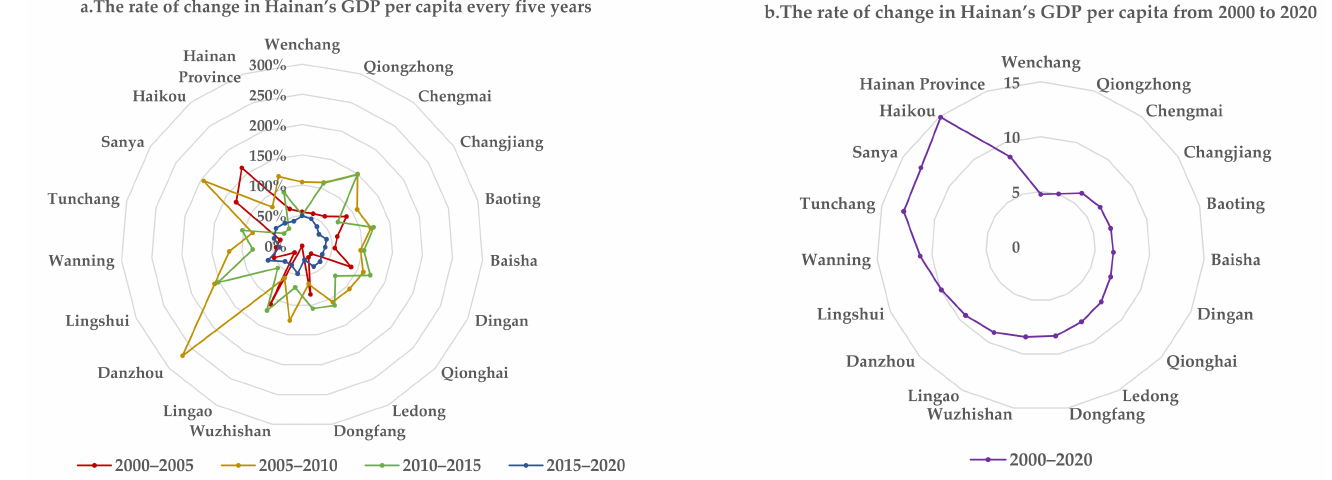
Figure 11. GDP per capita change rate of each city and county in Hainan. ( a ) The rate of change in Hainan’s GDP per capita every five years, and ( b ) the rate of change in Hainan’s GDP per capita from 2000 to